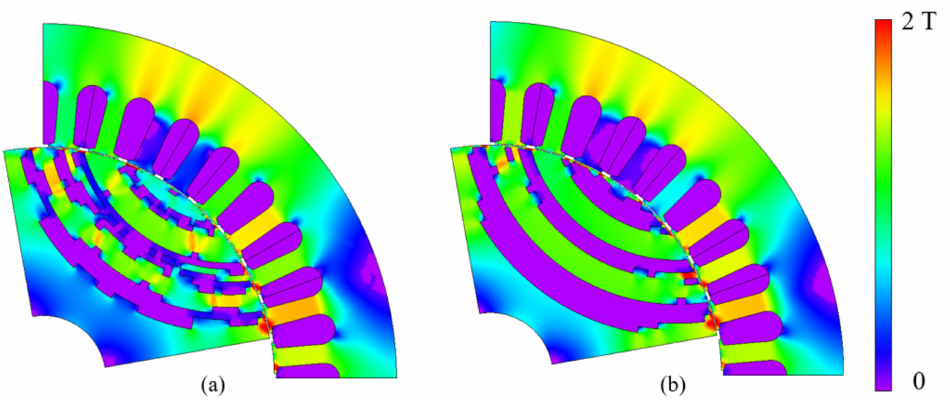
Figure 10. Shape and magnetic flux density of the model resulting from the ON-OFF method. ( a ) Step 1; ( b ) Step 4.